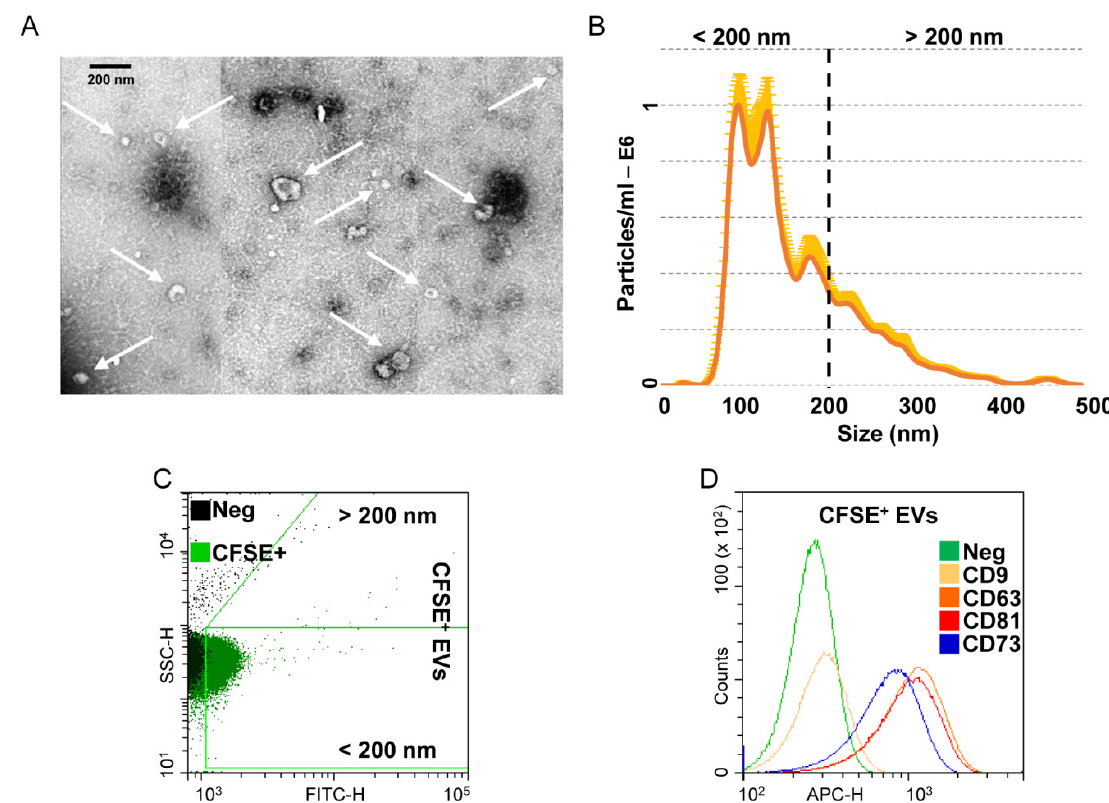
Figure 3. Characterization of EVs from OA-SF treated ASCs. ( A ) Transmission electron micrographs of EVs showing characteristic cup-shaped morphology. ( B ) Mean particle size analysis from NTA data. ( C , D ) EVs flow cytometry analysis. EVs were CFSE stained to allow identification and gating of vesicles in the FITC channel. After gating, CFSE+ EVs showed positive staining for extracellular vesicle defining molecules CD63 and CD81 and MSC marker CD73. CD9, another EV postulated marker, was barely detectable. Representative cytograms are presented.